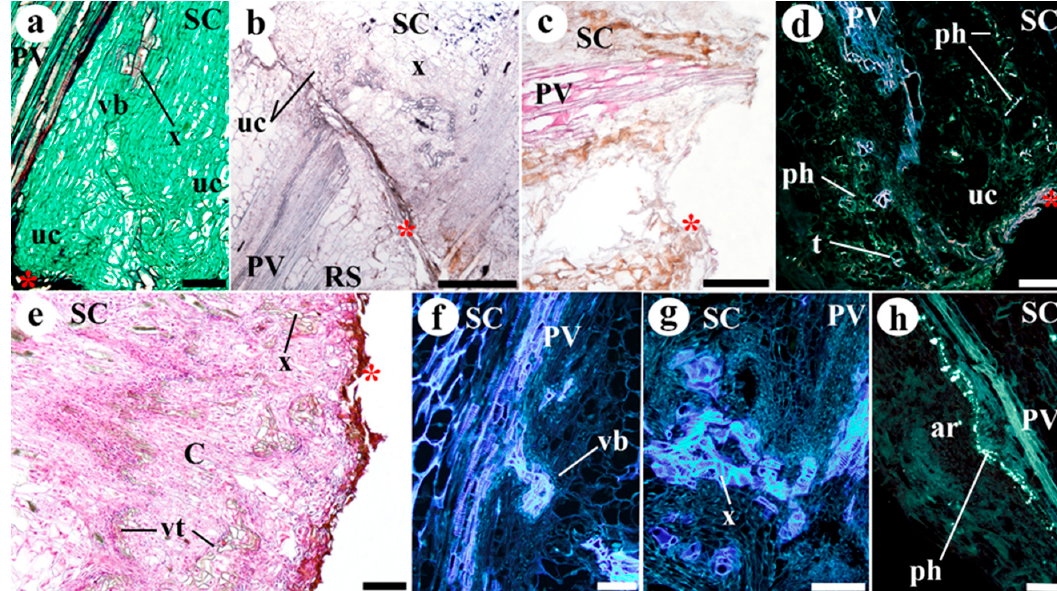
Figure 6. Representative images of non ‐ functional ( e ) homografts and ( a – d , f – h ) heterografts at ( a – d ) 10 and ( e – h ) 20 days after grafting (DAG). ( a ) Marmande VR (scion)–Minibel (rootstock) heterograft.